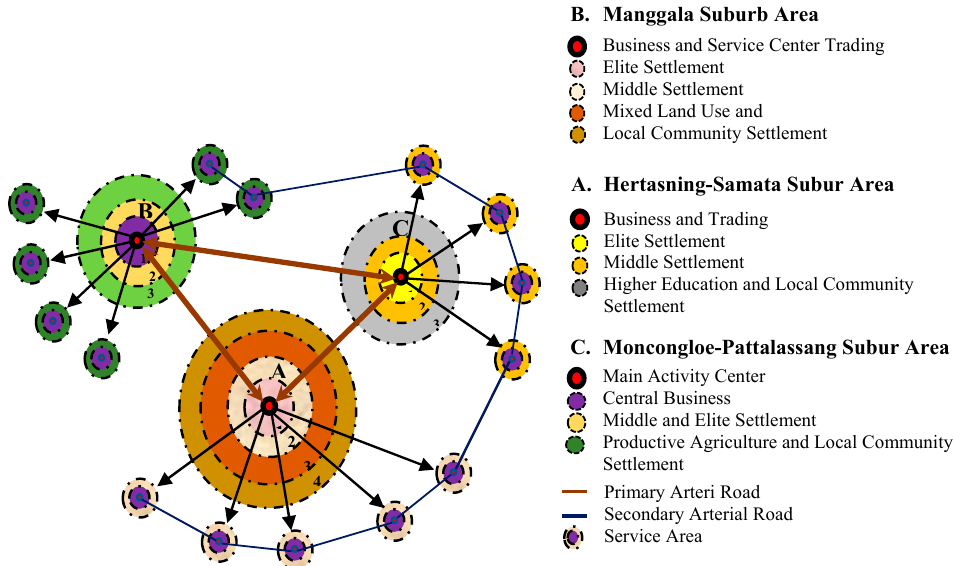
Figure 10. Comparison of the Mamminasata Metropolitan Suburbs Space Structure. Source: author elaboration.